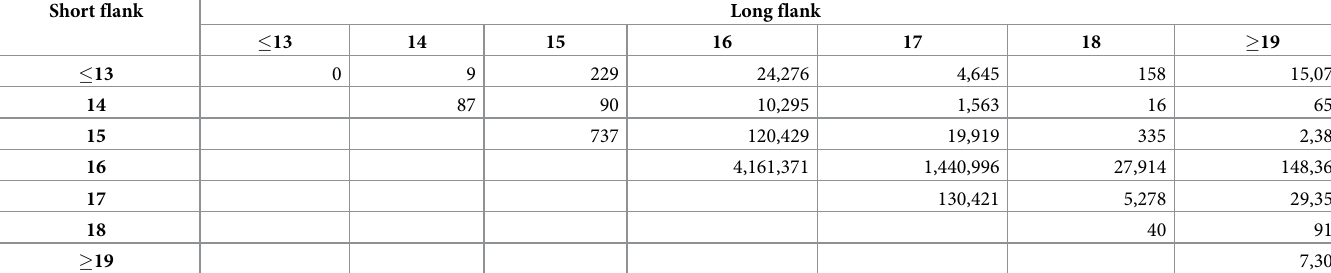
Table 3. Flank length analysis of all reference-matching, motif-containing reads derived from Illumina DHB4 run. Short flank